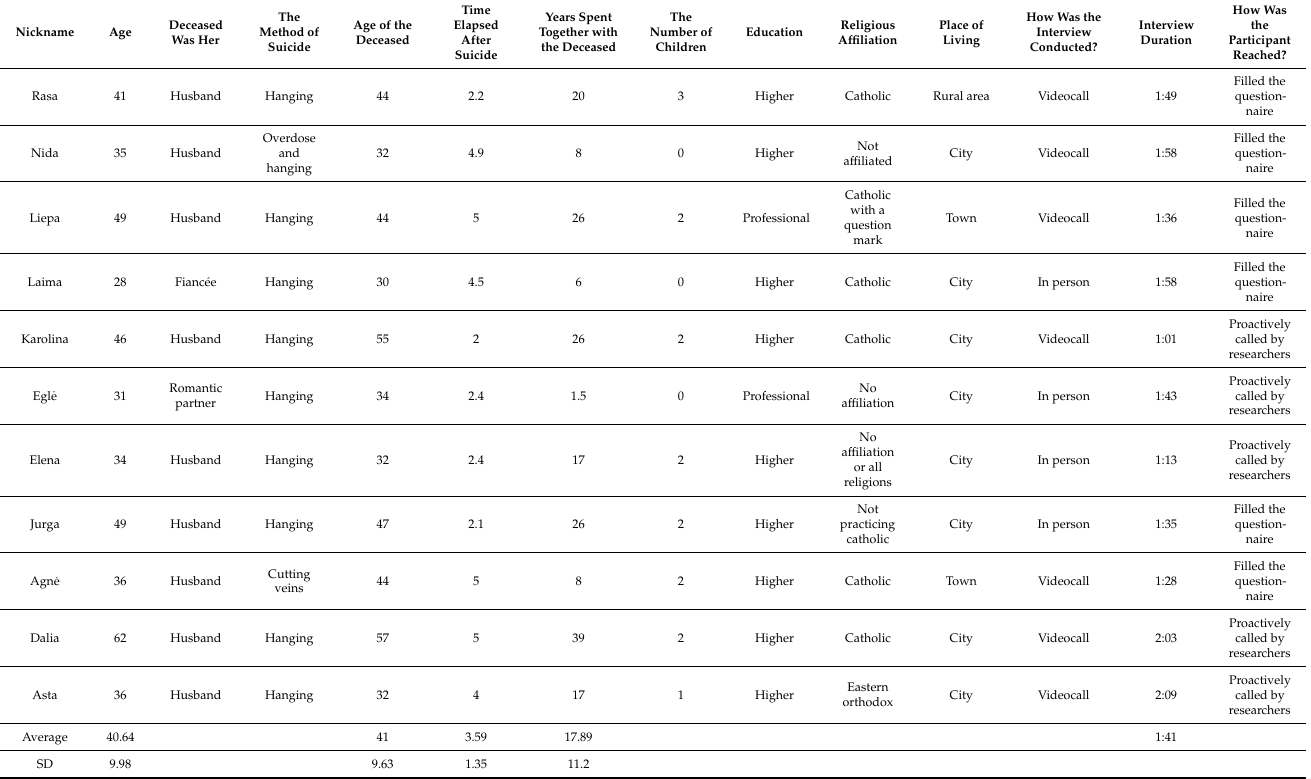
Table 1. Characteristics of the interviewees and